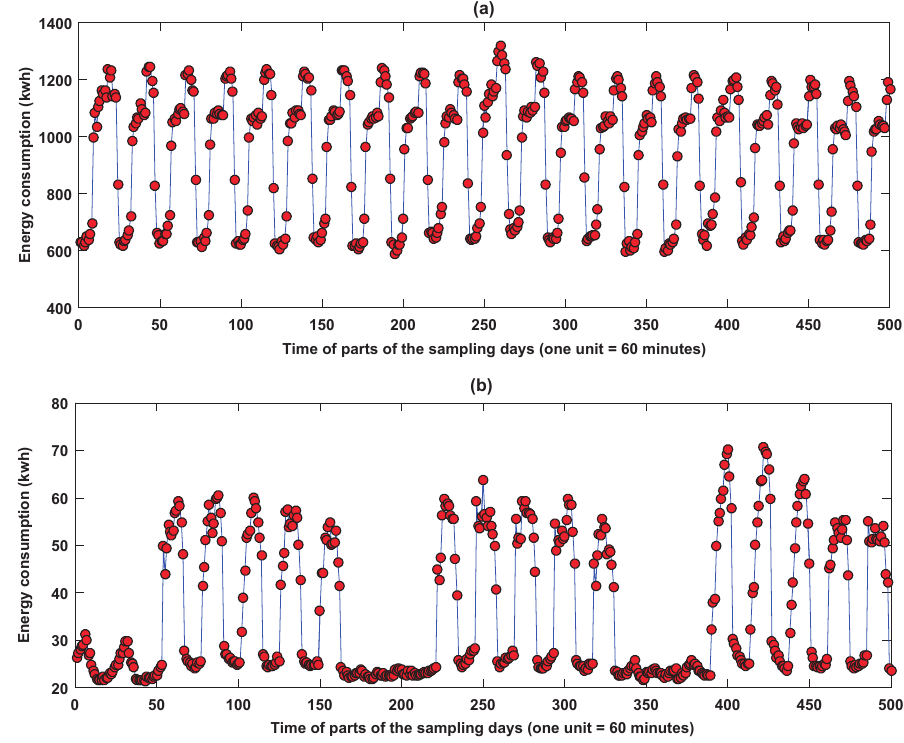
Figure 7. Parts of the samples of two data sets: ( a ) the first 500 data points of the retail store; ( b ) the first 500 data points of the office